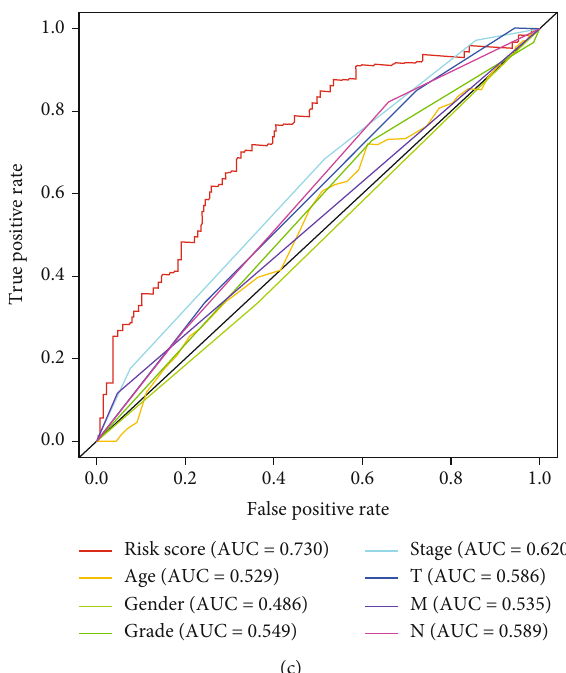
Figure 4: Independent risk factor analysis in the whole TCGA set. (a) Univariate and (b) multivariate Cox regression analyses were performed to calculate the hazard ratio (HR) and p value for each parameter. (c) AUC values of risk score, age, gender, grade, and TNM